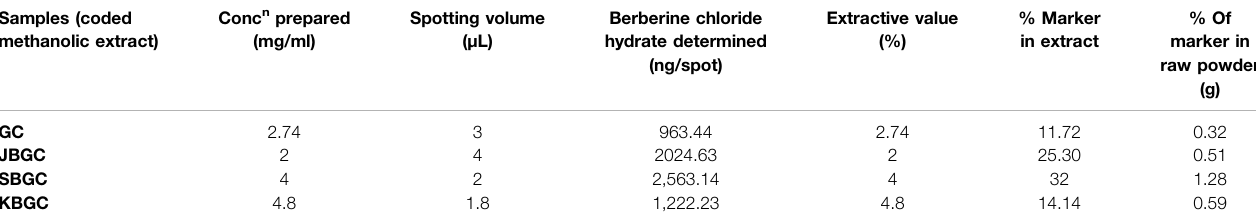
TABLE 3 | The berberine chloride hydrate present in different codi fi ed samples. Samples (coded methanolic